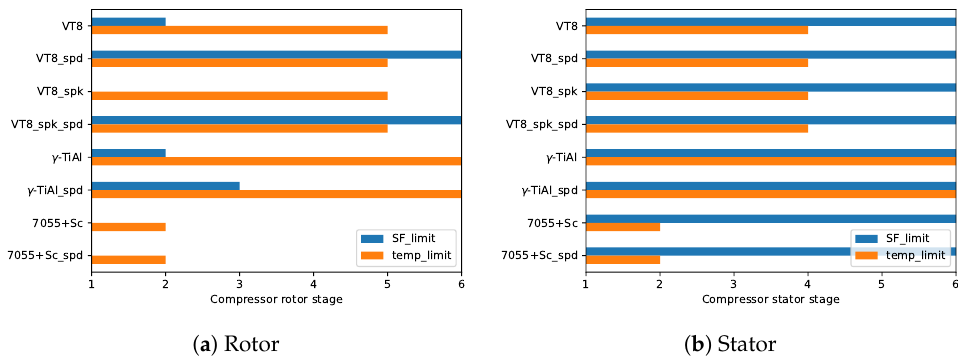
Figure 10. Rotor and stator stages for which the strength and temperature limits of materials are